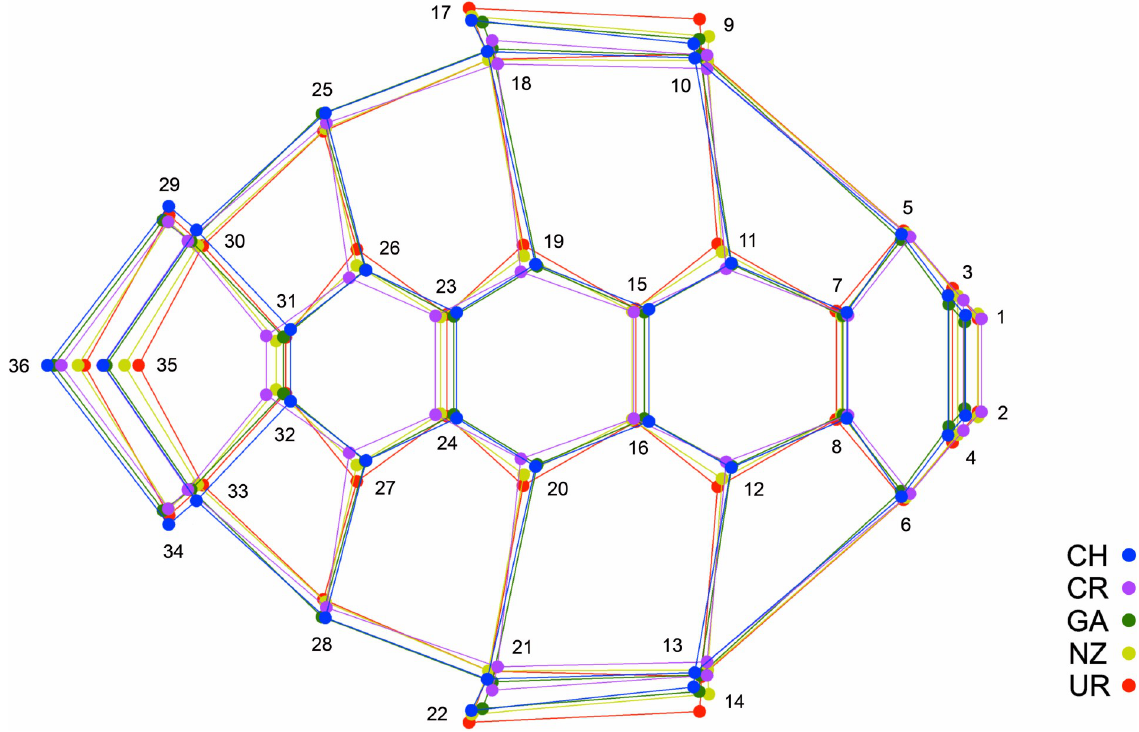
Fig 5. Wireframe representation of the carapace shape variation and their corresponding landmarks from foraging grounds. Uruguay: red; Costa Rica: pink; Galapagos, Ecuador: green; Chile: blue, and New Zealand: yellow.